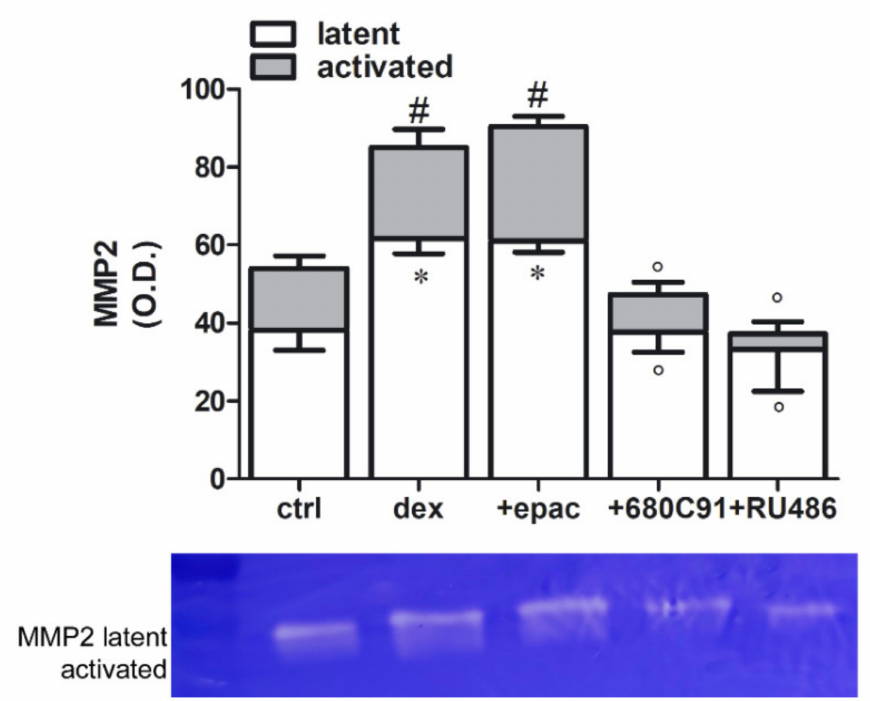
Figure 8. Gelatin zymography for matrix metalloproteinases (MMP2) production in response to dex alone or in presence of epacadostat (1 µ M) or 680C91 (40 µ M) or RU486 (1 µ M). Results are reported as mean ± SEM of band densitometry, n = 5. * p < 0.05 vs. latent MMP2 and # p < 0.05 vs. activated MMP2 of control unstimulated cells (ctrl); ◦ p < 0.05 vs. dex